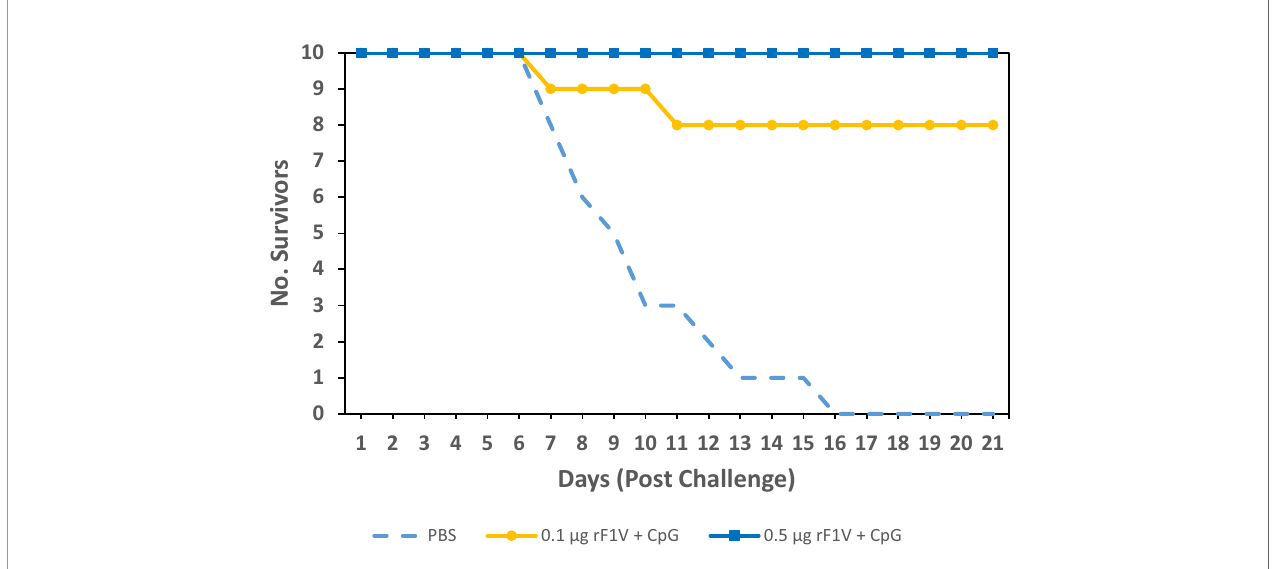
FIGURE 6 | Adjuvanation of rF1V with CpG improves protection against Y. pestis C12 subcutaneous challenge. BALB/c mice were vaccinated with two subcutaneous doses, 3 weeks apart with mock/PBS, 0.1 µg or 0.5 µg of rF1V with 5 µg CpG (n=10). At 29 days post vaccination, BALB/c mice were subcutaneous challenged with 3.6x10 3 CFU (approximately 400 LD 50 equivalents) of Y. pestis C12. Survival was monitored for 21 days post